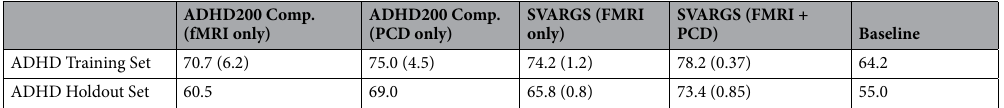
Table 5. Binary (TDC/ADHD) classification accuracy of different methods on ADHD200 data set. The table shows cross-validated accuracies on the original training set and the accuracies obtained on the original holdout set. Standard deviations are shown in brackets. The first column shows the best accuracies obtained in the ADHD-200 Global Competition 68–70 . The second column shows the ADHD-200 Global Competition using PCD only. The best accuracies in the ADHD-200 Global Competition were obtained using only the personal characteristic data. The third and fourth columns show the accuracy using SVARGS+CGC features (4.2.4) and the adaboost-SAMME algorithm for classification with only fMRI and fMRI+PCD respectively. The last column merely lists the proportions of the majority class for each emotion and sets the baseline accuracy. The accuracies shown for our methods is the average over 10 meta runs. The accuracy on each each meta run is the aggregate over 8 runs of the modal accuracy in the last 75 out of 225 rounds of 12 fold cross-validation. The accuracy on the holdout set is the average over 20 runs at the 50th round of